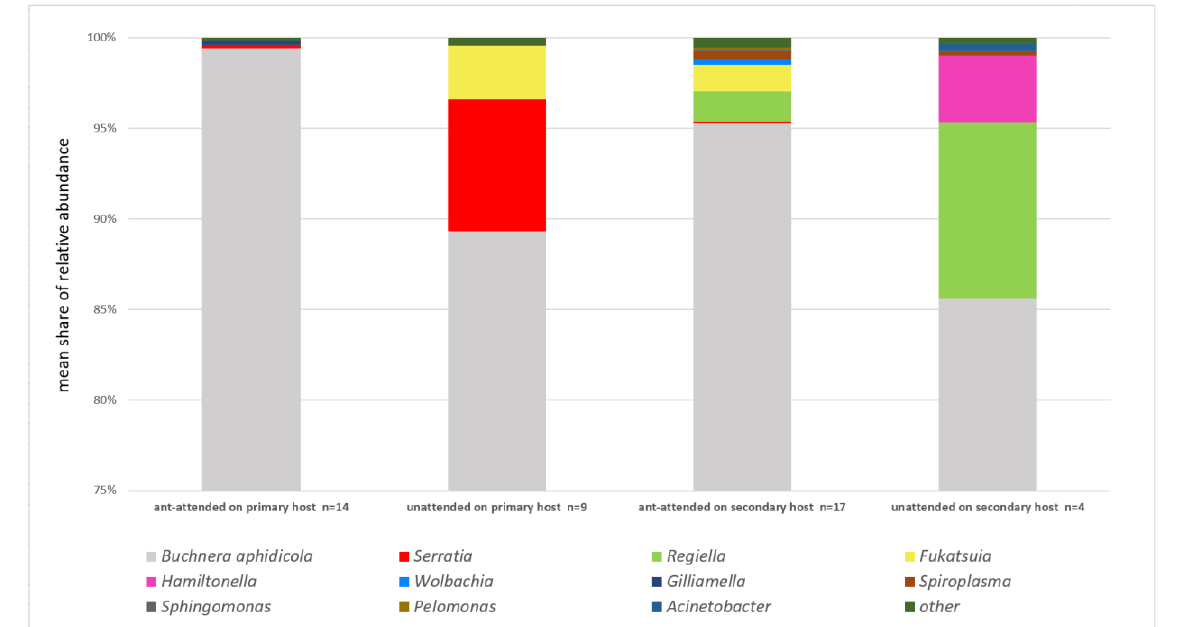
Figure 2. Shares of endosymbionts on aphid hosts in reference to ant attendance.